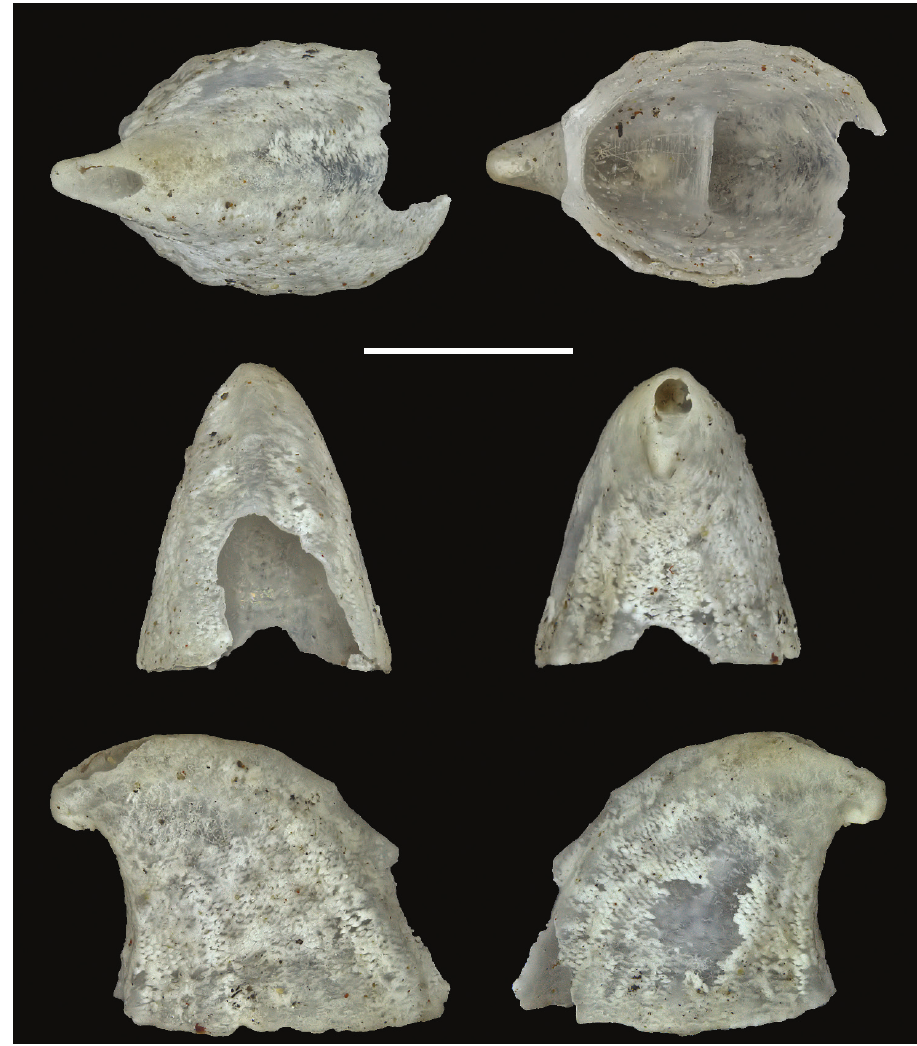
Figure 11. Puncturella ( Vacerrena ) christiaensi Kilburn, 1978. Holotype T2204/NMSA-MOL 0B230. Scale bar: 1